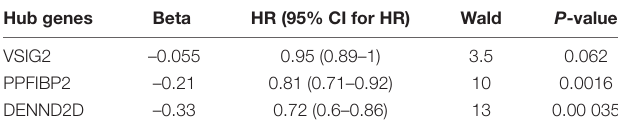
TABLE 2 | Univariate Cox regression analysis of hub